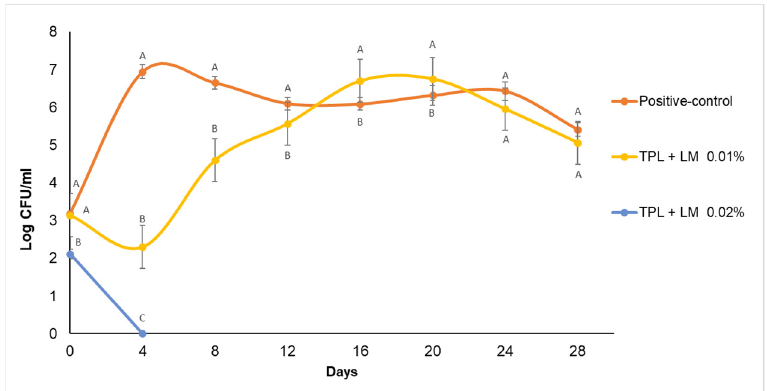
Figure 5. Effect of combining lemon myrtle (LM) with Tasmanian pepper leaf (TPL) nanoemulsion essential oil on the growth rate of Zygosaccharomyces bailii in clear apple juice during 28 days of storage at 25 °C. Means with different letters on the same day are significantly different at p < 0.05. The positive-control group of clear apple juice samples spiked with yeast but without treatment had 3.2 log CFU/mL initially at day-0, but experienced a significant ( p < 0.05) yeast growth at day-4 of 6.8 log CFU/mL. There were no significant differences within